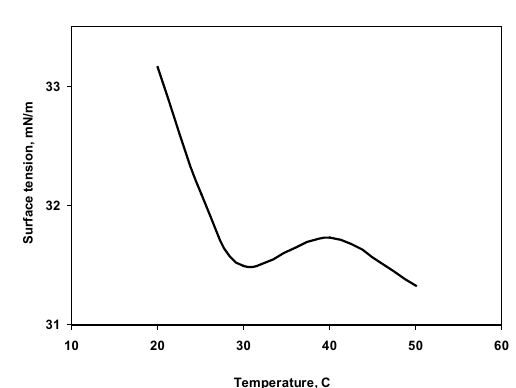
Figure 2. Surface tension dependence on temperature for 0.2 g dL -1 ferrocenyl-disiloxane polyamide in DMF.